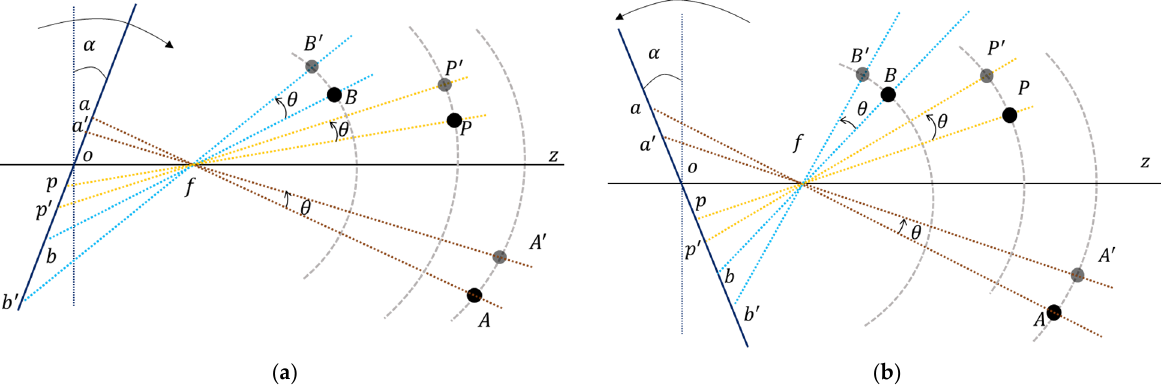
Figure 7. Changes of the targets before and after the camera rotation about the 𝑦 -axis. ( a ) Tilt the sensor (image plane) right. ( b ) Tile the sensor (image plane) left.